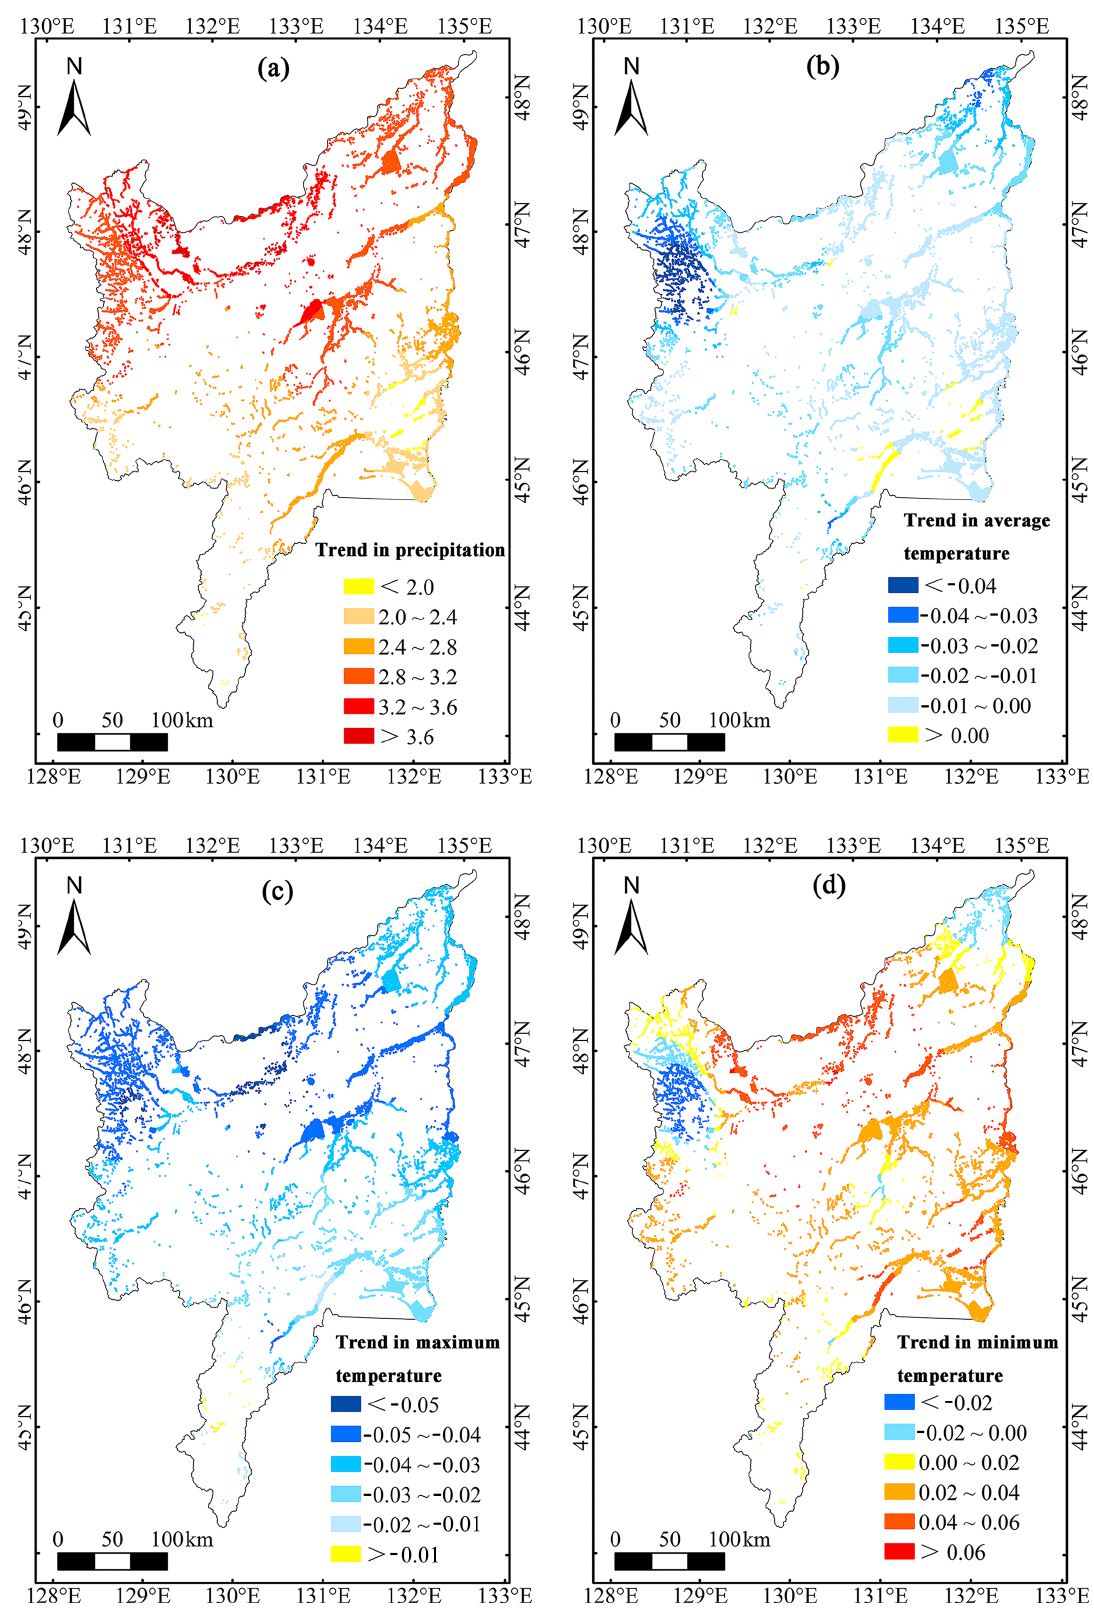
Figure 7. Change trends in growing season ( a ) precipitation (mm/year), ( b ) T mean (°C/year), ( c ) T max (°C/year) and ( d ) T min (°C/year) in the study region from 2000 to 2020.